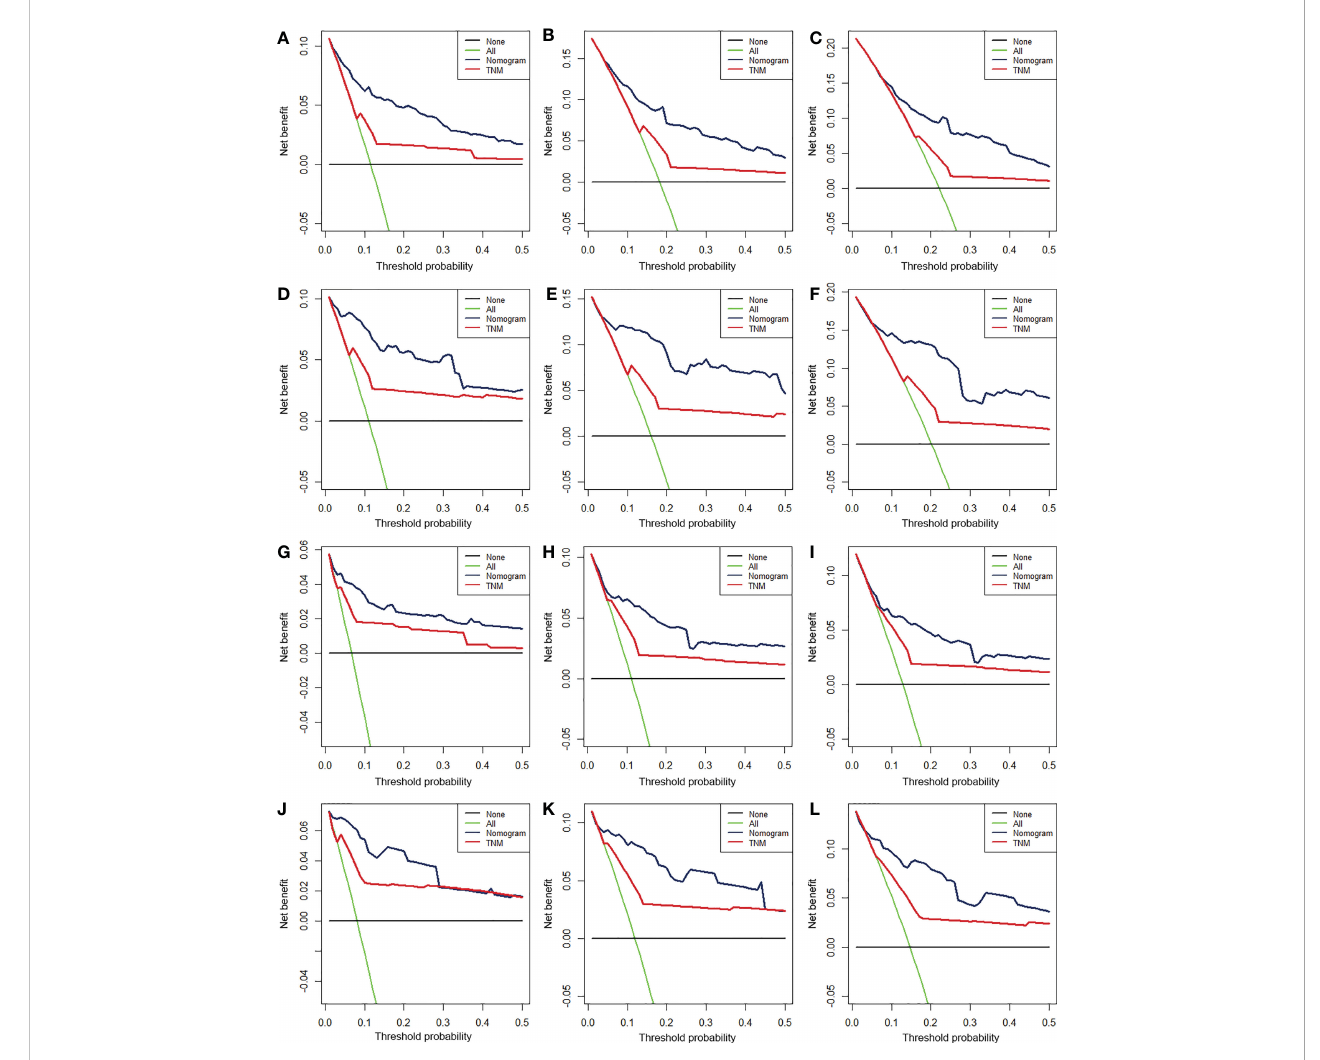
FIGURE 7 The decision curve analysis (DCA) of 24- (A) , 36- (B) , and 48-month (C) OS in the training cohort and 24- (D) , 36- (E) , and 48-month (F) OS in the veri fi cation cohort and of 24- (G) , 36- (H) , and 48-month (I) CSS in the training cohort and 24- (J) , 36- (K) , and 48-month (L) CSS in the veri fi cation